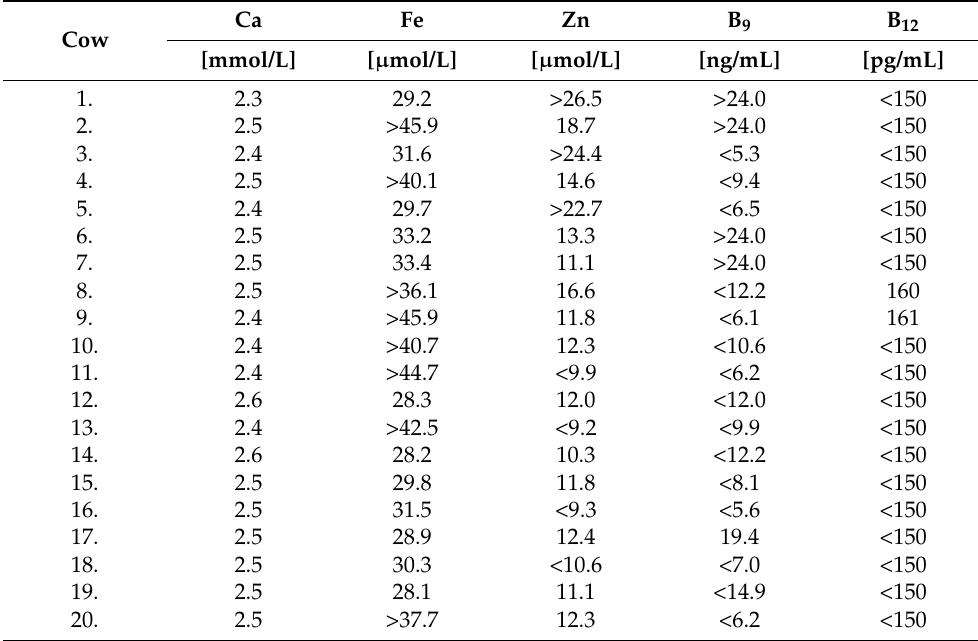
Table 2. Content of selected micro- and macroelements and vitamins in the blood serum of cows.